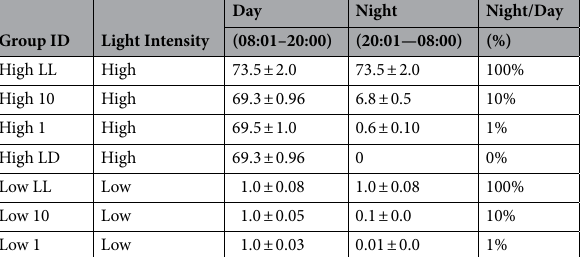
Table 1. Light exposure treatments. *Units = µmol m −2 s −1 . Recorded light intensity (µmol m −2 s −1 ) measurements of each group (mean ±